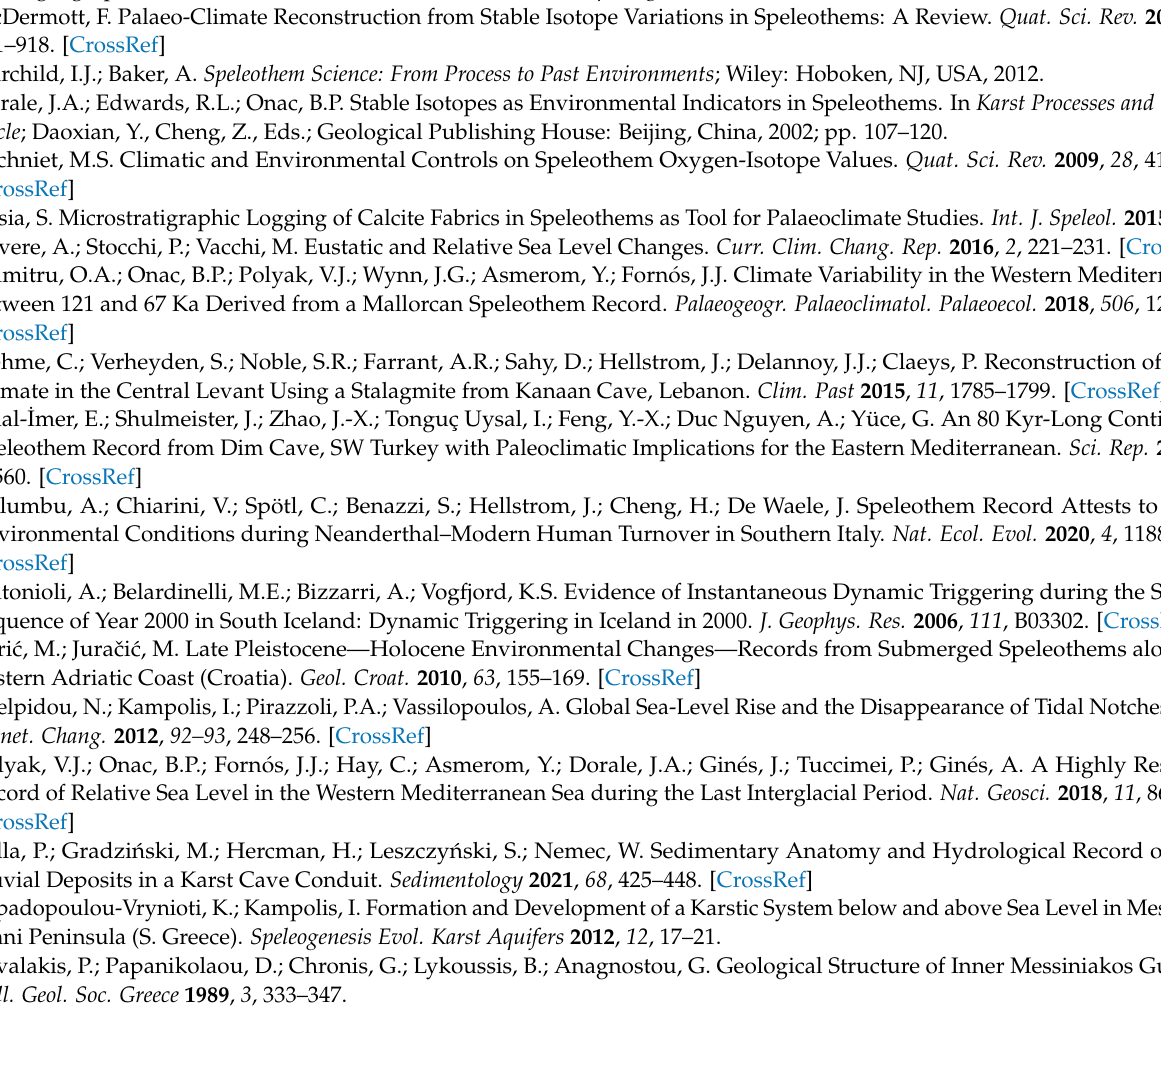
Table S1: Representative major (wt.%) and trace (ppm) element analyses of the fine-grained deposits in Selinitsa